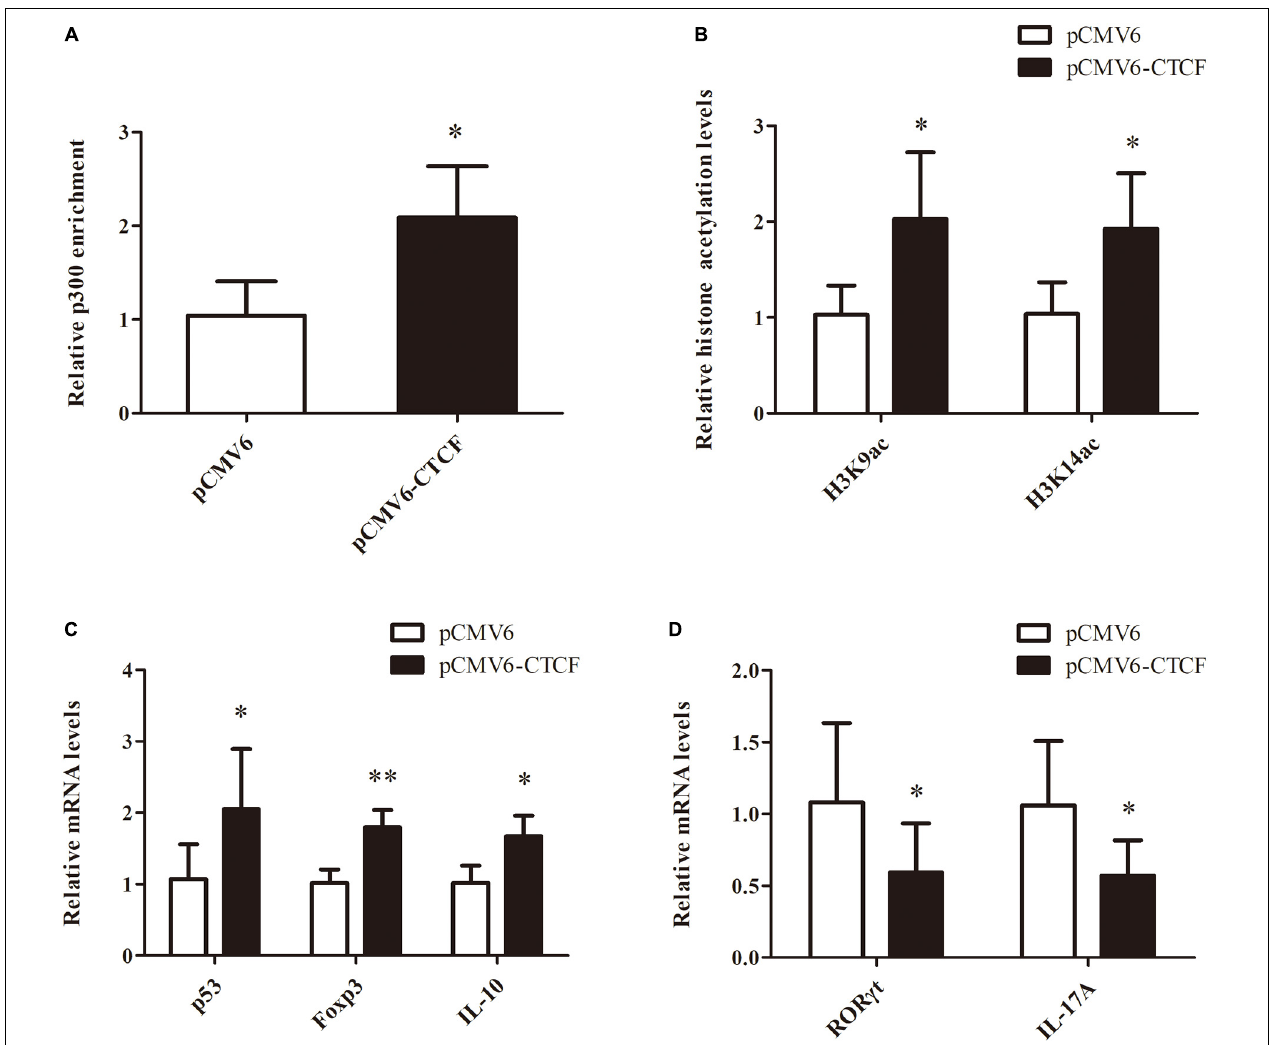
FIGURE 6 | Restoring CTCF expression in CD4 + T cells from aGVHD cases improves Treg/Th17 cell imbalance by increasing p53 expression. (A , B) ChIP-qPCR analysis of the enrichment of p300 binding (A) and H3K9/K14 (B) acetylation levels in the p53 promoter region in CD4 + T cells from three separate aGVHD cases after CTCF overexpression. Values are relative to those obtained with input DNA prepared from untreated chromatin. Data are mean ± SD from three independent experiments. (C , D) Real-time PCR analysis of p53, Foxp3, IL-10 (C) , ROR γ t, and IL-17A (D) expression levels in CD4 + T cells from three separate aGVHD cases after CTCF overexpression. Data are mean ± SD from three independent experiments. ∗ P < 0.05, ∗∗ P <